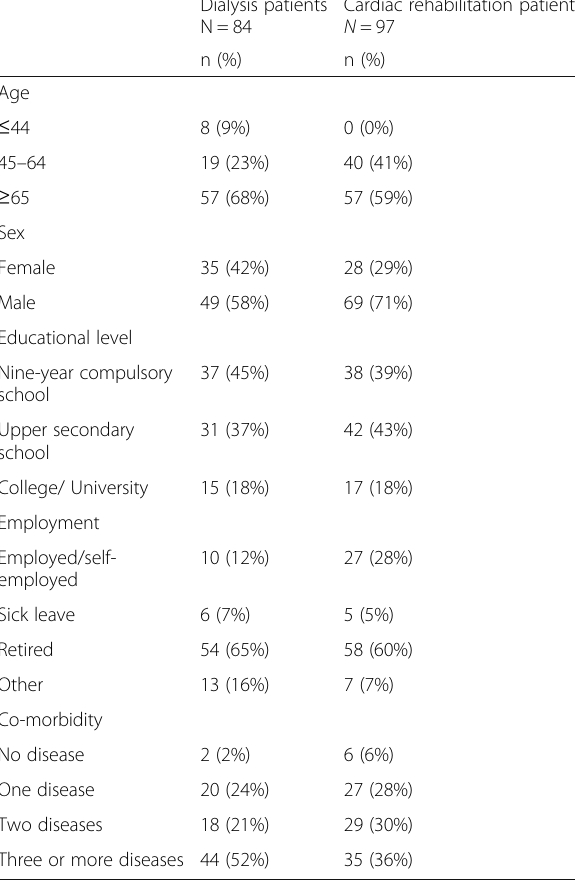
Table 2 Age, sex, educational level, employment, and co-morbidity by patient group